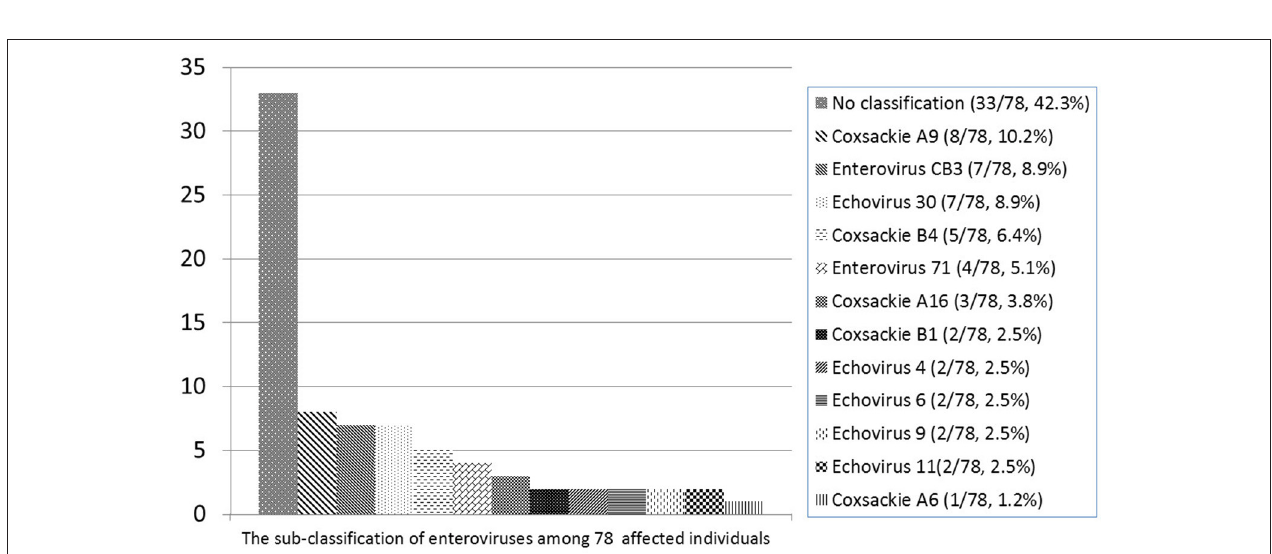
FIGURE 3 | Subclassification of enteroviruses among 78 affected